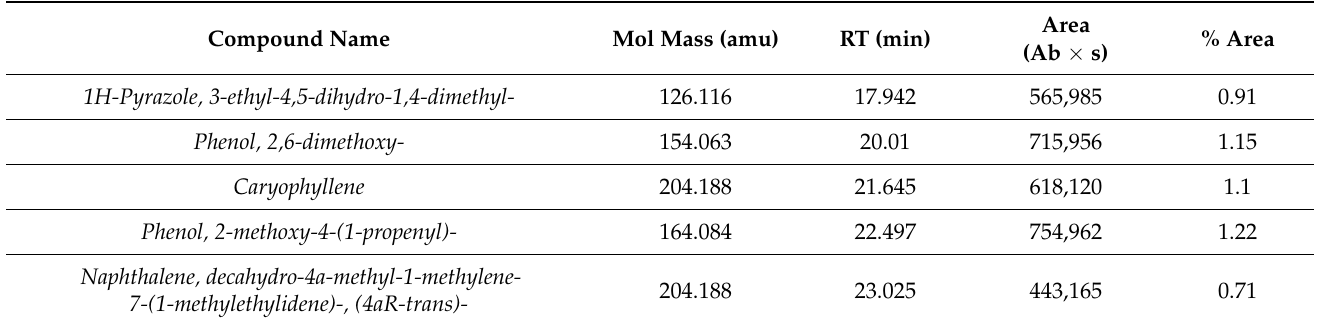
Table 3. Chemical composition analysis of ethanol extract C. calcitrapa